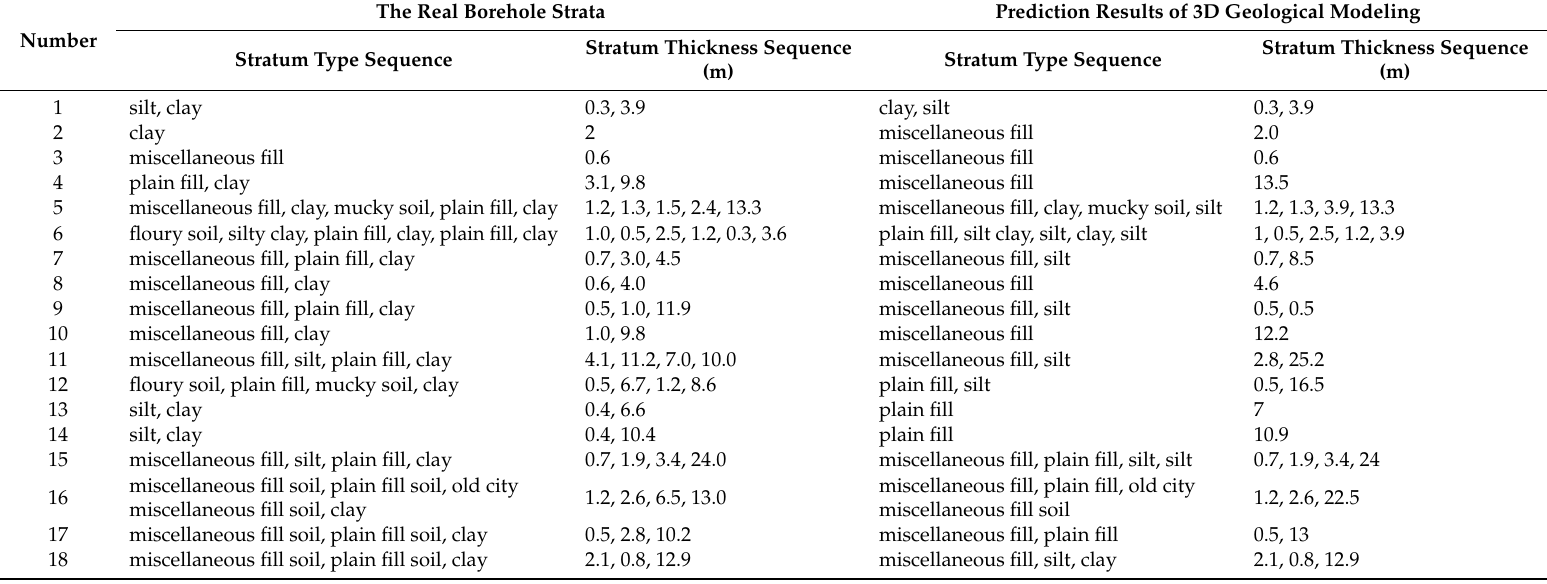
Table 10. Comparison of the real borehole stratum conditions and 3D geological modeling prediction